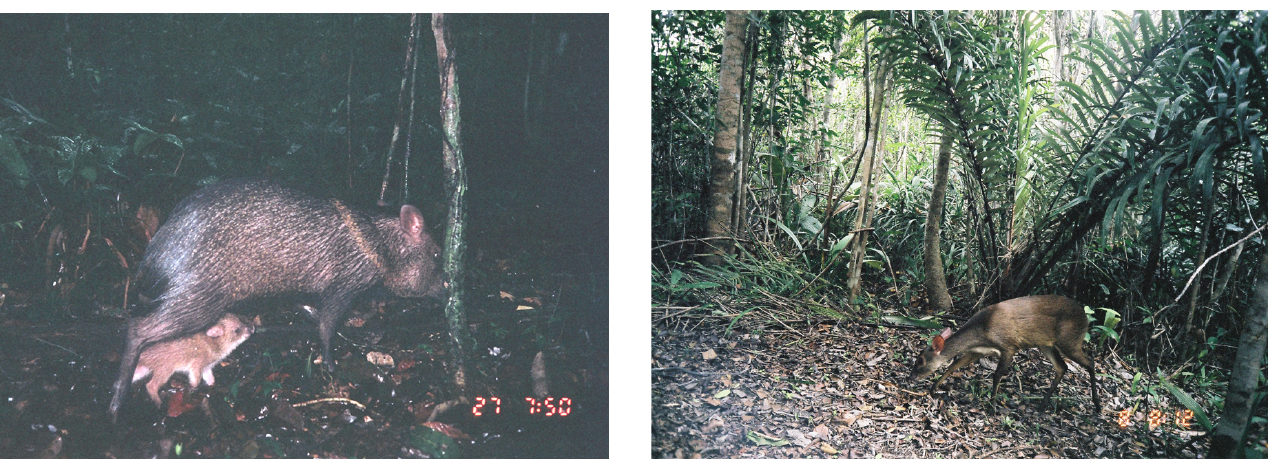
Pecari tajacu Figure 6. Collared peccary ( ) with infant, recorded in the Reserve.